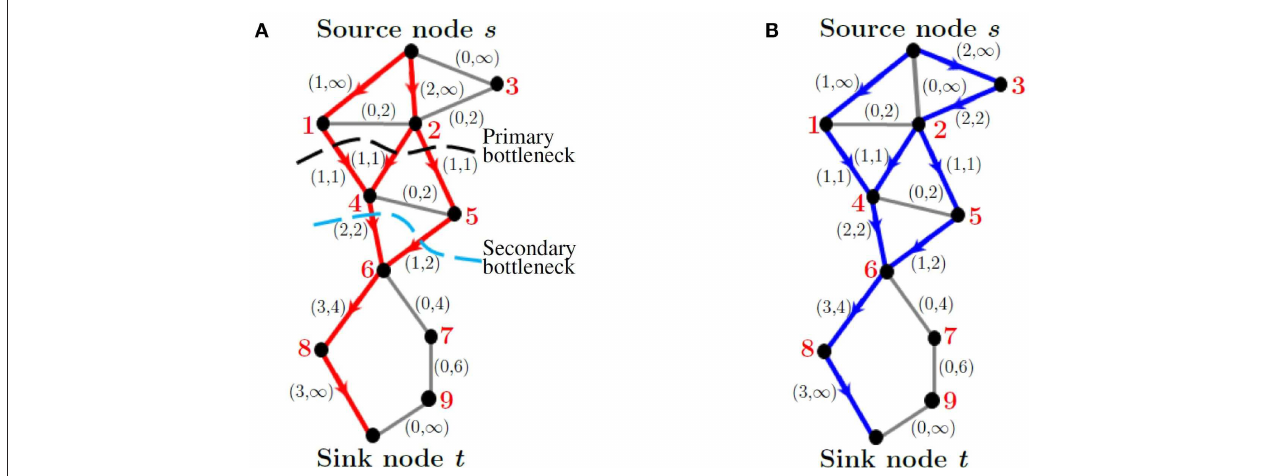
FIGURE 7 | (Color online) A depiction of the multiple concepts discussed in sections 4.1–4.4. Two examples of a feasible ( s , t )-flow with maximum flow F ∗ = 3. Link labels are of the form ( x e , u e ). (A) Maximum flow pathways with unit cost P (red arcs), primary bottleneck or minimum cut (black dashed line), and secondary bottleneck (light blue dashed line). (B) Maximum flow pathways without cost (blue arcs). Gray arcs in (A,B) are not part of the maximum flow pathways: arcs with zero